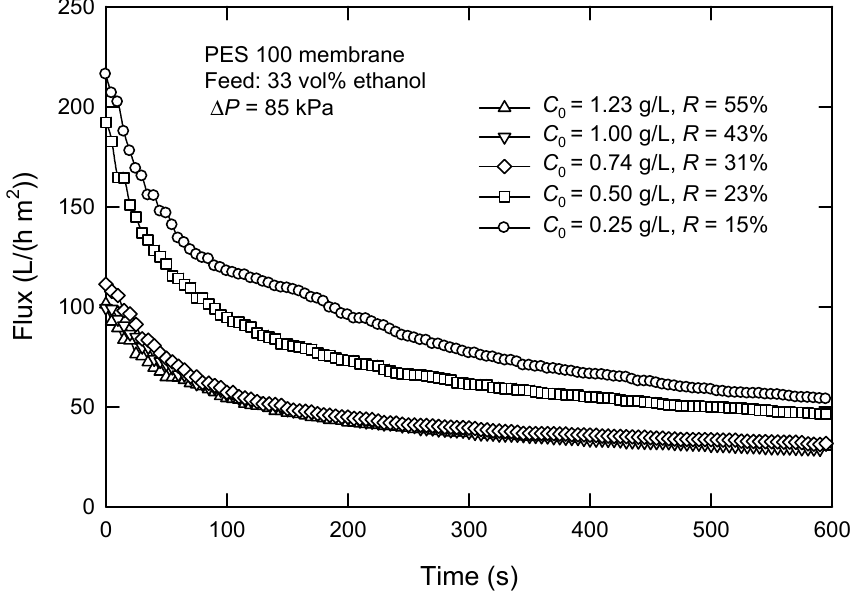
Figure 6. Effect of surfactin concentration C 0 on the flux and surfactin rejection in dead-end UF.